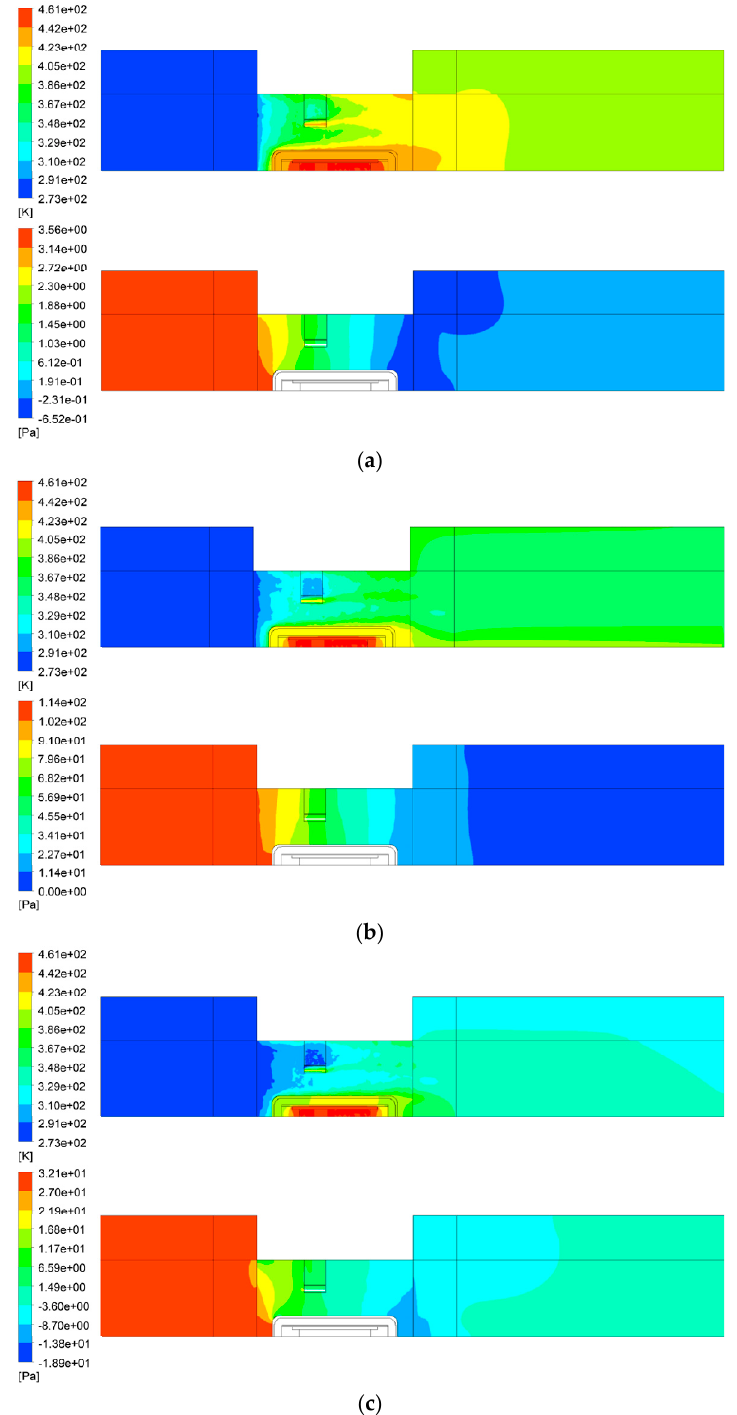
Figure 10. Temperature (up) and pressure drop (down) contours at different mass flow rates ( a ) 100 kg/h, ( b ) 300 kg/h, and ( c ) 500 kg/h.